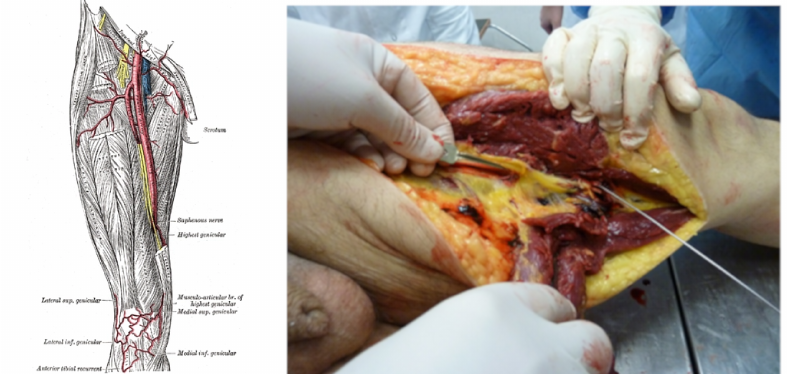
Figure 4. Anatomic representation of femoral artery ( left panel , figure from https://radiopaedia. org/articles/femoral-artery, accessed on 10 January 2023); femoral artery injury ( right panel )